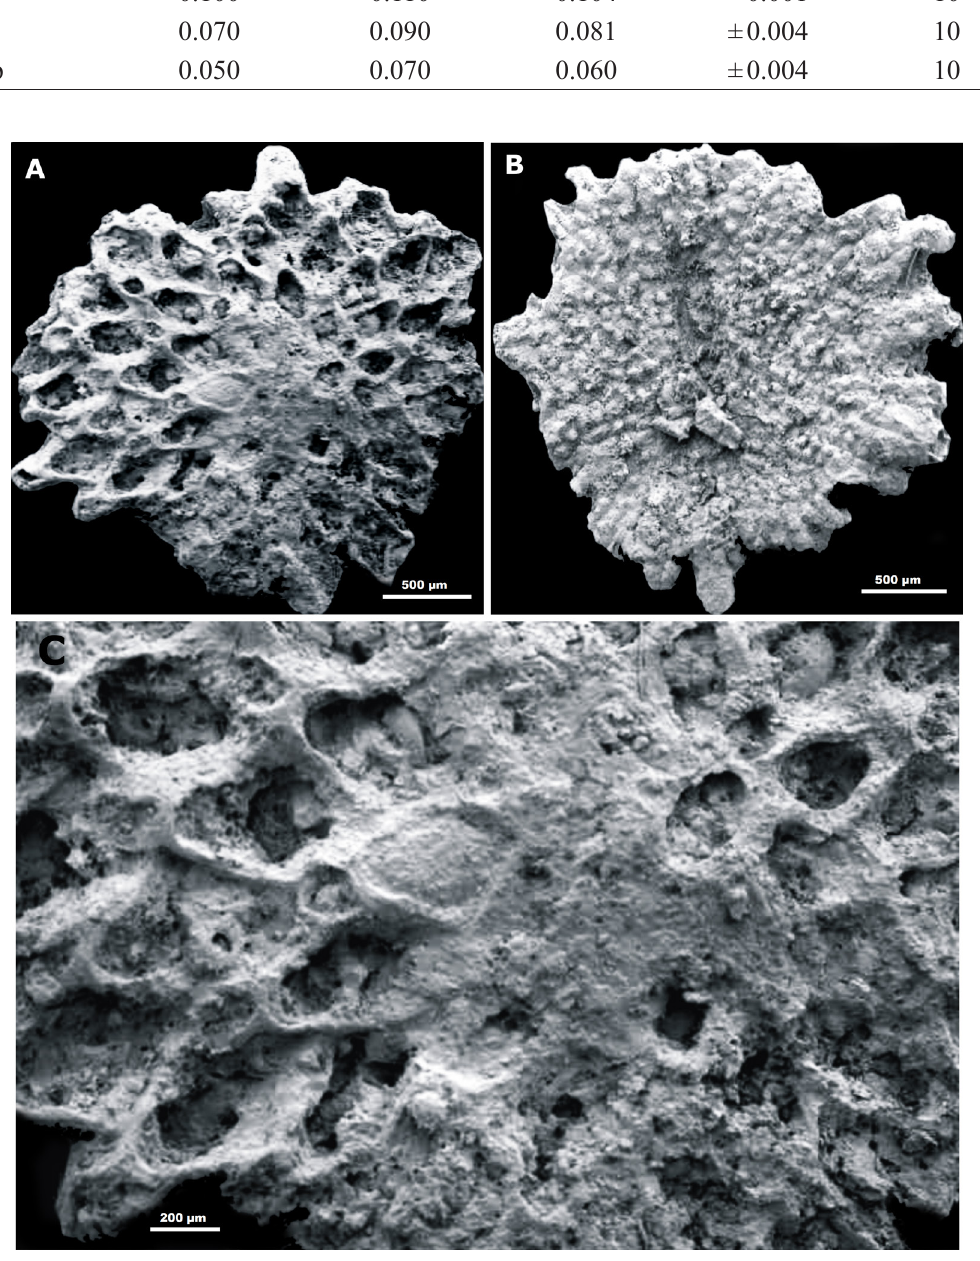
Fig. 6. Cupuladria sp . (GIS/B 0471). A . General view of the colony showing autozooids and vibracula on the distal periphery. B . Basal view of the colony showing more or less irregular inconspicuous tangential grooves with basal kenozooidal pores in the form tubercles. C . Close-up of the colony showing autozooids and